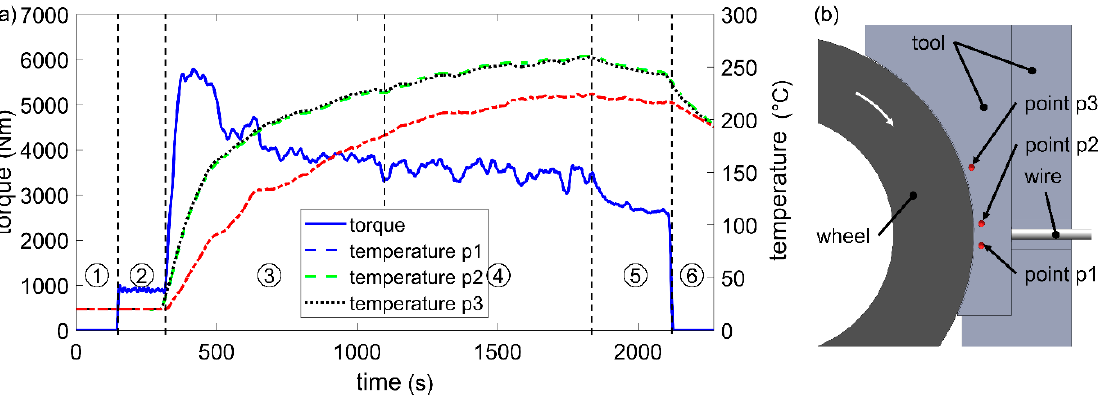
Figure 4. Determination of the dependence of the process variables in the test with EN-AW-6060 chips, a round die of 5 mm and a rotational speed of 6 rpm. ( a ) Development of the torque and the external tool temperatures. ( b ) Illustration of the temperature measuring points.